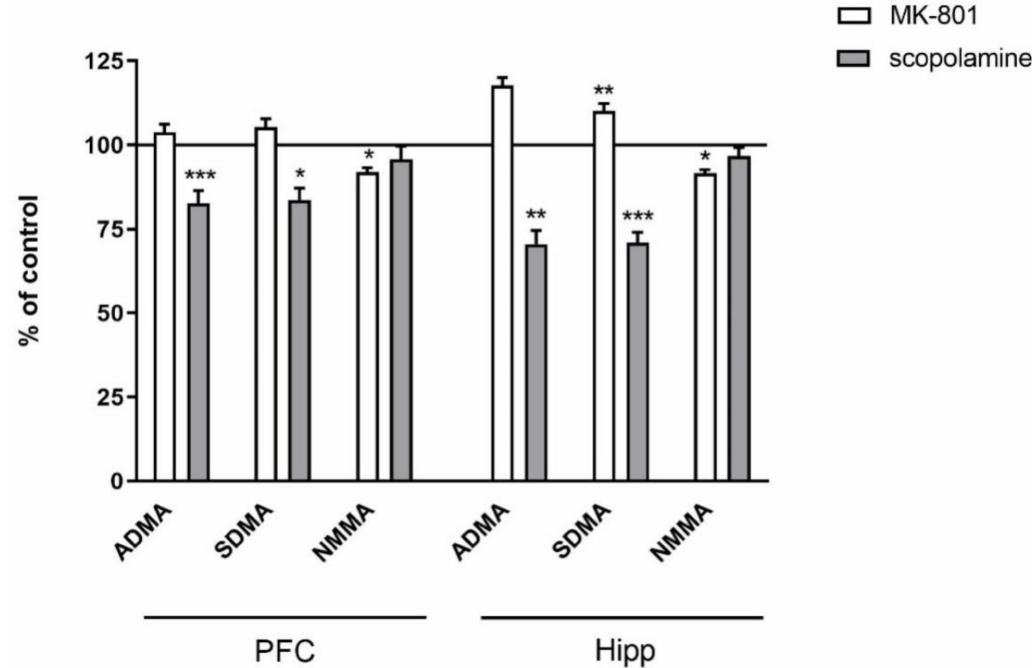
Figure 2. ADMA, SDMA and NMMA levels in the prefrontal cortex (PFC) and hippocampus (Hipp) after acute admin- istration of MK-801 (0.3 mg/kg) or scopolamine (1 mg/kg). Data are presented as means ± SEM. * p < 0.05; ** p < 0.01; *** p < 0.001 vs.